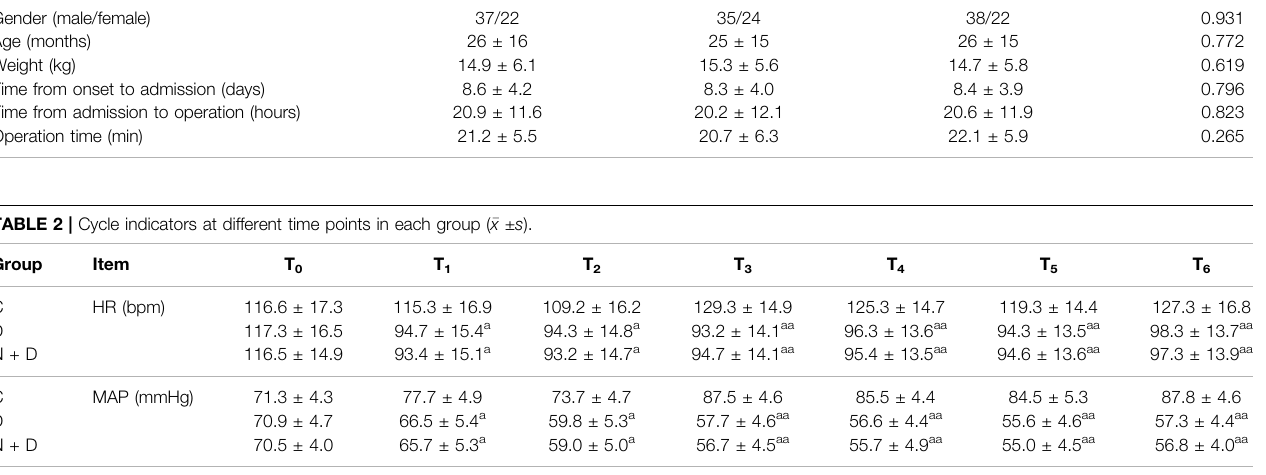
Gender (male/female)